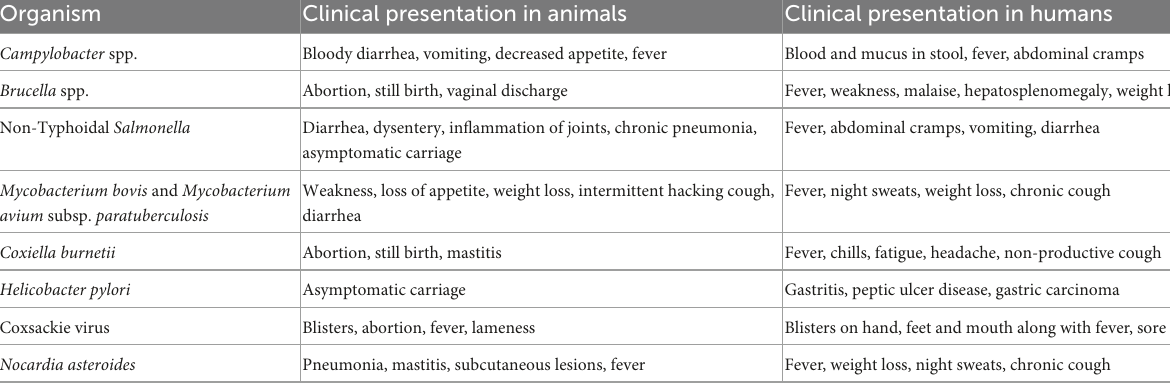
TABLE 1 Clinical features of milk borne pathogens in animals and humans. Organism Clinical presentation in animals Clinical presentation in humans Campylobacter spp.